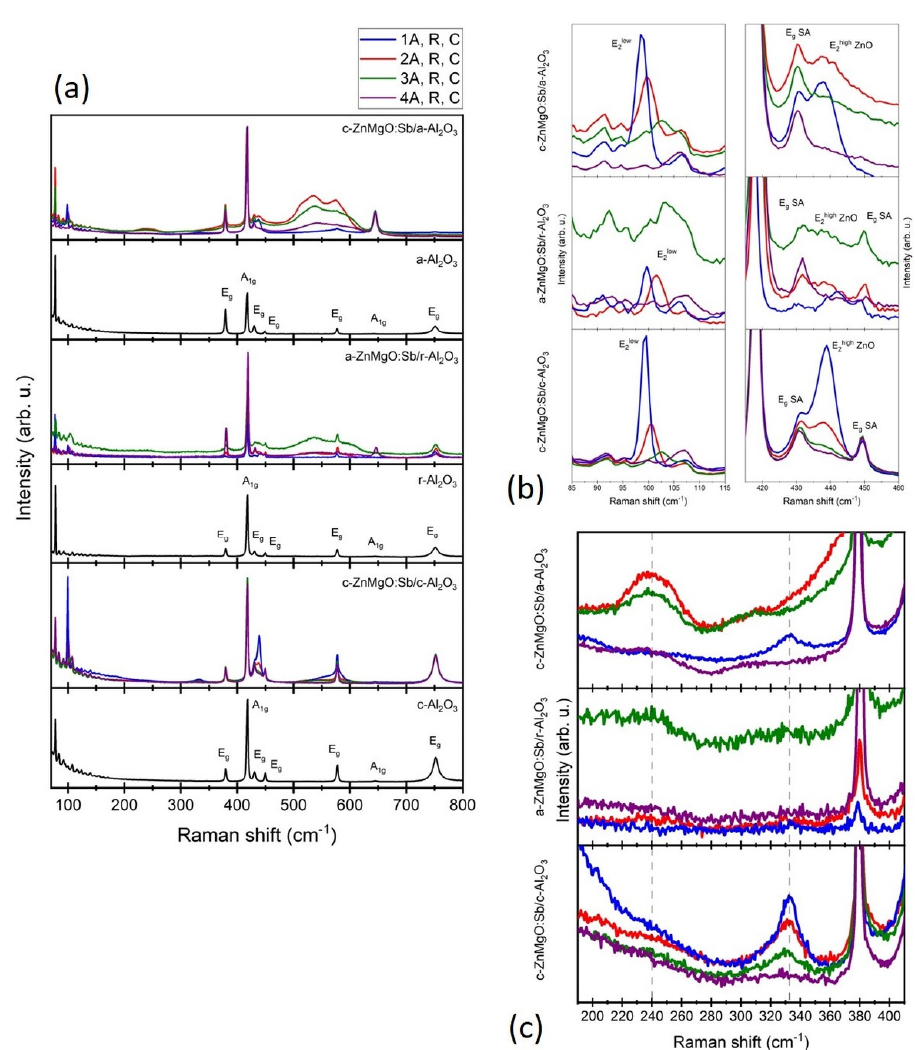
Figure 9. ( a ) Room temperature Raman spectra of c ‐ Zn 1 − x Mg x O:Sb/ a ‐ Al 2 O 3 , a ‐ Zn 1 − x Mg x O:Sb/ r ‐ Al 2 O 3 , and c ‐ Zn 1 − x Mg x O:Sb/ c ‐ Al 2 O 3 samples with corresponding substrates; λ exct = 514.5 nm, P exct = 20